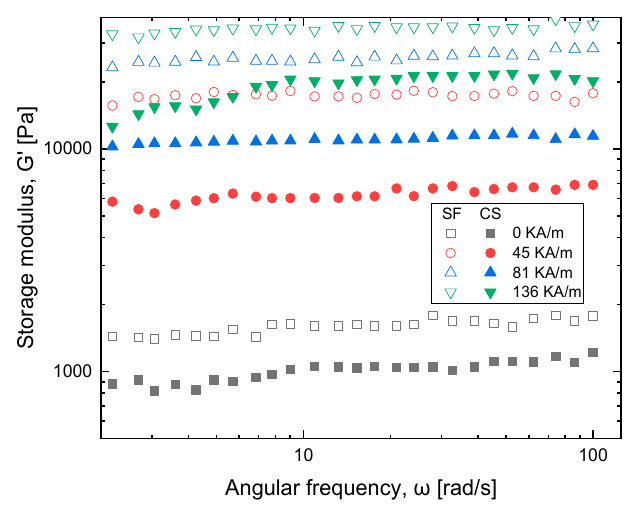
Figure 9. Storage modulus as a function of angular frequency at variable magnetic field strength for sunflower (SF) and cottonseed (CS) blend based MR fluid.